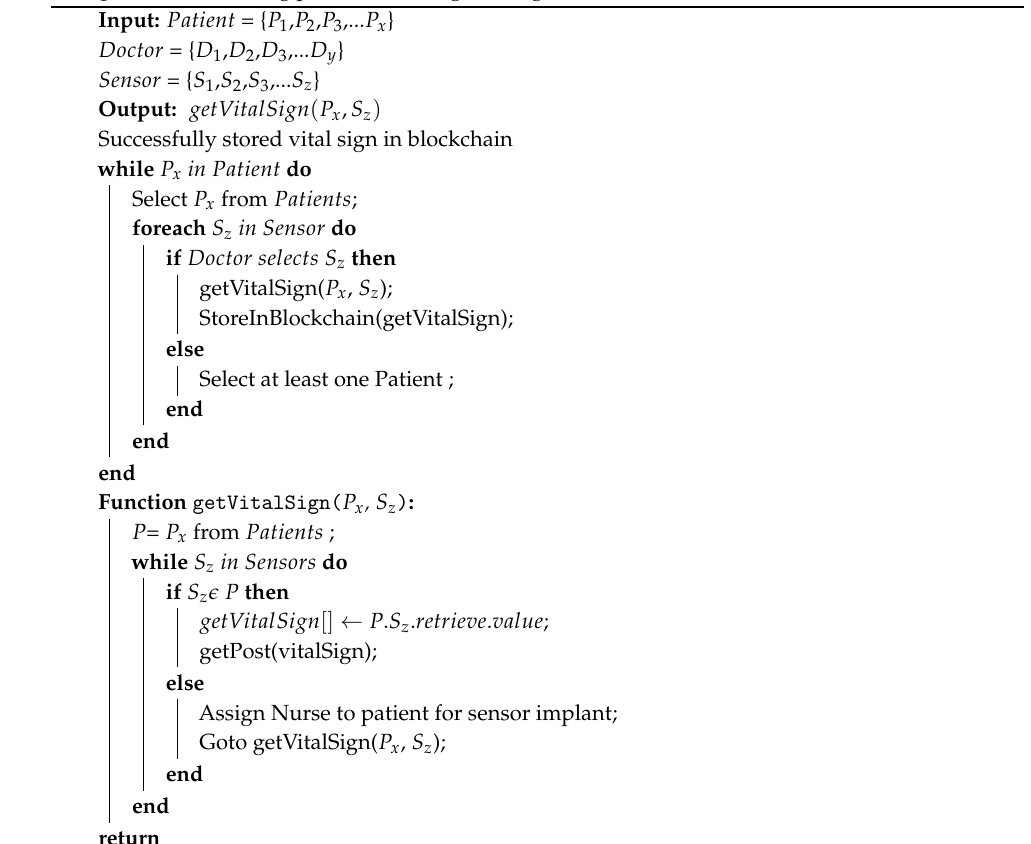
Algorithm 1: Securing patient’s vital signs using